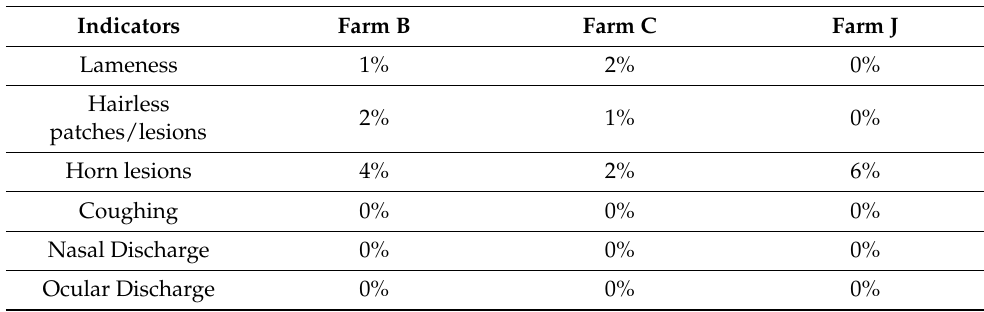
Table 5. Results for the indicators in absence of disease and absence of injuries in the three study